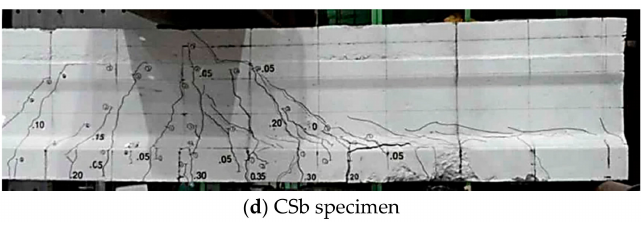
Figure 11. Failure crack patterns of the shear specimens.